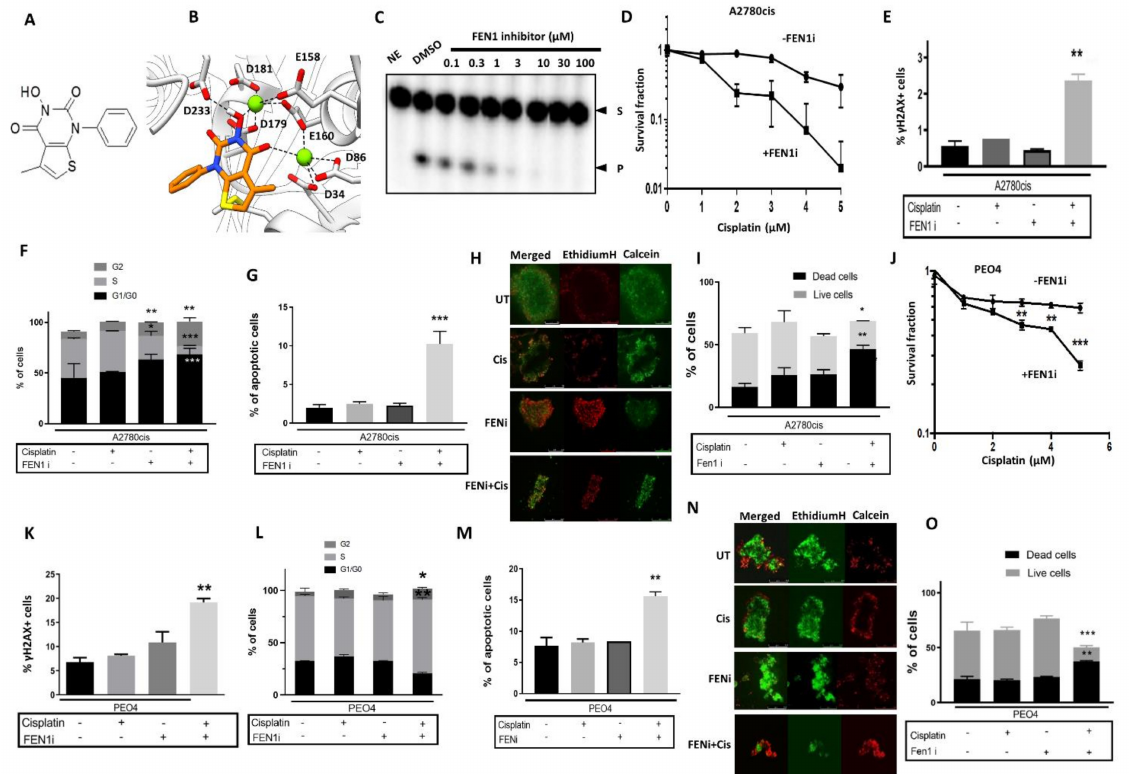
Figure 4. ( A ) Chemical structure of FEN1 inhibitor. ( B ) Docking of FEN1 inhibitor in the FEN1 crystal structure. ( C ) FEN1 cleavage assay. FEN1 inhibitor was added at the indicated concentration. The absence of a lower band indicates FEN1 inhibition. See methods for details. ( D ) Clonogenic assay in cisplatin-treated A2780cis cells with or without FEN1 inhibitor. ( E ) γ H2AX analysis by flow cytometry in cisplatin-treated A2780cis cells with or without FEN1 inhibitor. ( F ) Cell cycle progression in cisplatin-treated A2780cis cells with or without FEN1 inhibitor. ( G ) AnnexinV analysis by flow cytometry in cisplatin-treated A2780cis cells with or without FEN1 inhibitor. ( H ) Cisplatin sensitivity A2780cis spheroids with or without FEN1 inhibitor. ( I ) Quantification of dead and living cells in cisplatin-treated A2780cis spheroids with or without FEN1 inhibitor. ( J ) Clonogenic assay in cisplatin-treated PEO4 cells with or without FEN1 inhibitor. ( K ) γ H2AX analysis by flow cytometry in cisplatin-treated PEO4 cells with or without FEN1 inhibitor. ( L ) Cell cycle progression in cisplatin-treated PEO4 cells with or without FEN1 inhibitor. ( M ) AnnexinV analysis by flow cytometry in cisplatin-treated PEO4 cells with or without FEN1 inhibitor. ( N ) Cisplatin sensitivity PEO4 spheroids with or without FEN1 inhibitor. ( O ) Quantification of dead and living cells in cisplatin-treated PEO4 spheroids with or without FEN1 inhibitor. All figures are representative of 3 or more experiments. * = p value < 0.05, ** = p value < 0.01, *** = p value <